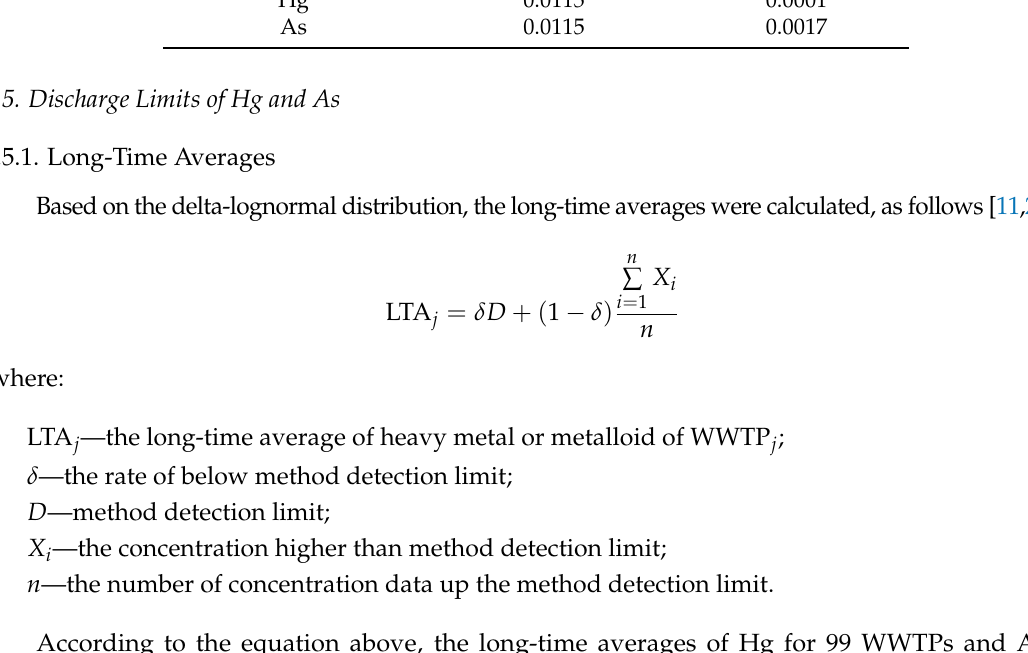
Table 6. Average of standard deviations of influent and effluent for Hg and As.